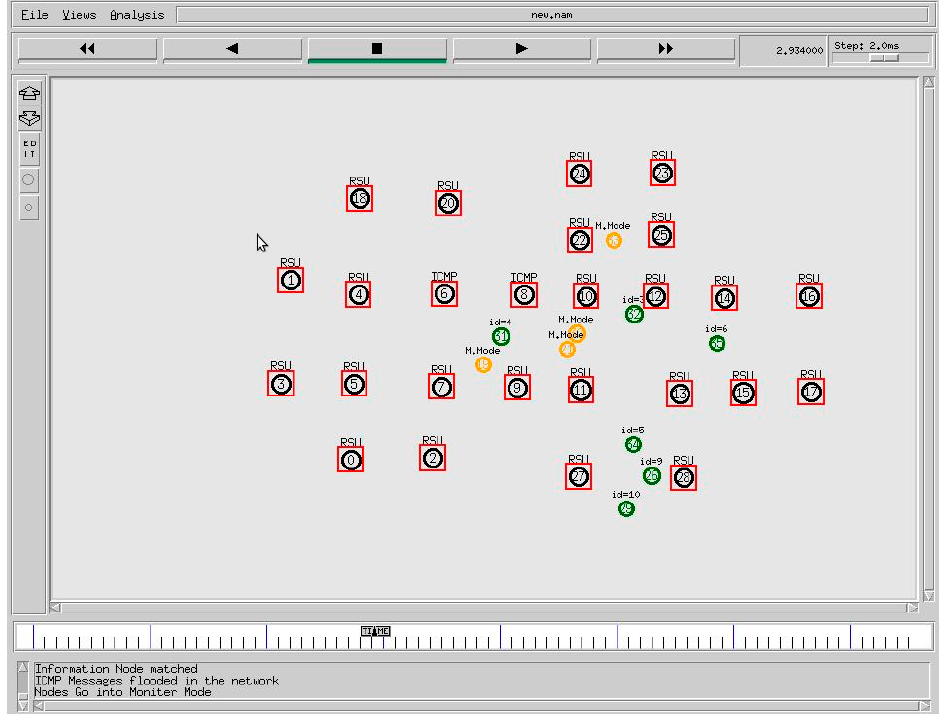
Figure 4. Nodes in monitor mode.